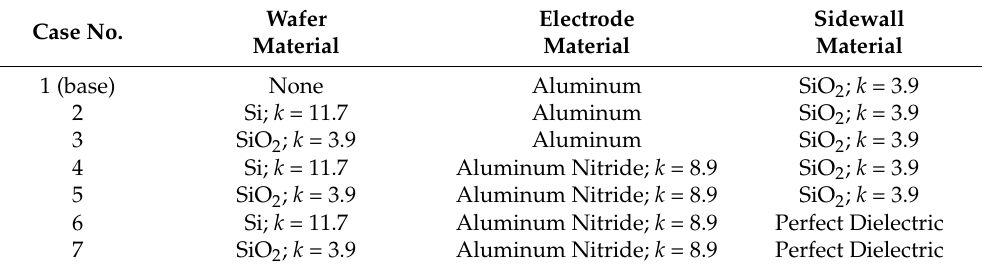
Table 1. List of cases considered in this study.